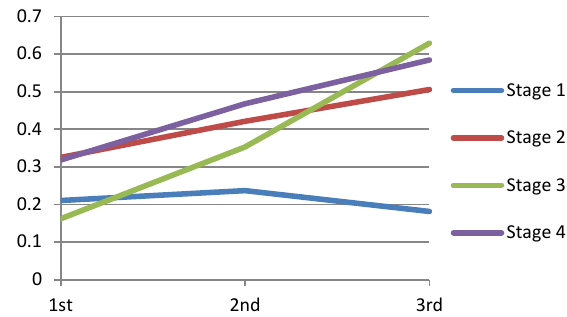
Figure 6: The average correctness development during the three parts of a